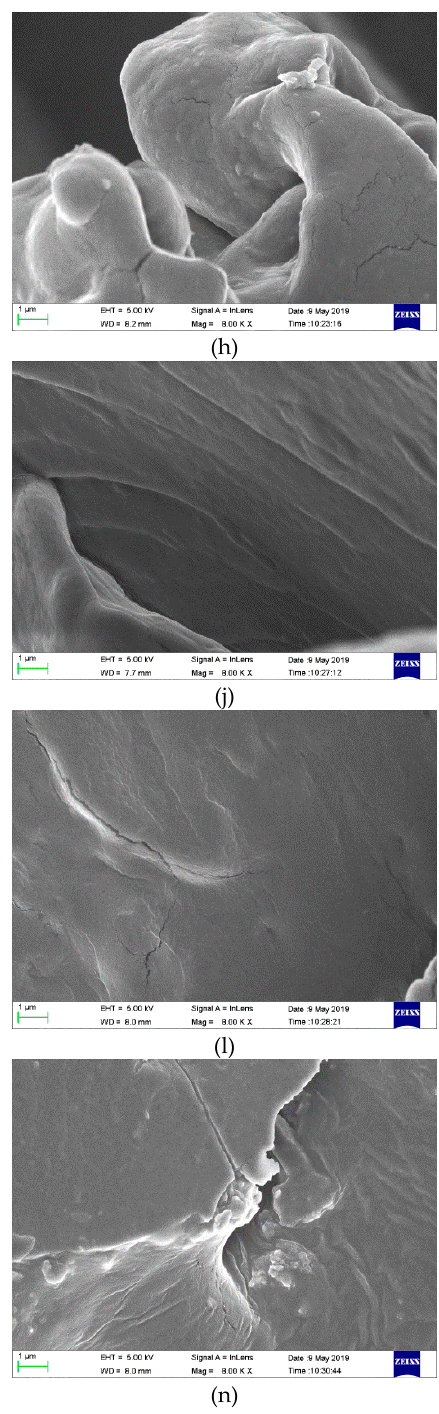
Figure 3. SEM micrographs of films: a , c , e , g , i , k , m (SAF, 10% WEF, 15% WEF, 20% WEF, 10% EEF, 15% EEF and 20% EEF, magnification: 50 × ) and b , d , f , h , j , l , n (SAF, 10% WEF, 15% WEF, 20% WEF, 10% EEF, 15% EEF and 20% EEF, magnification: 8000 × ).